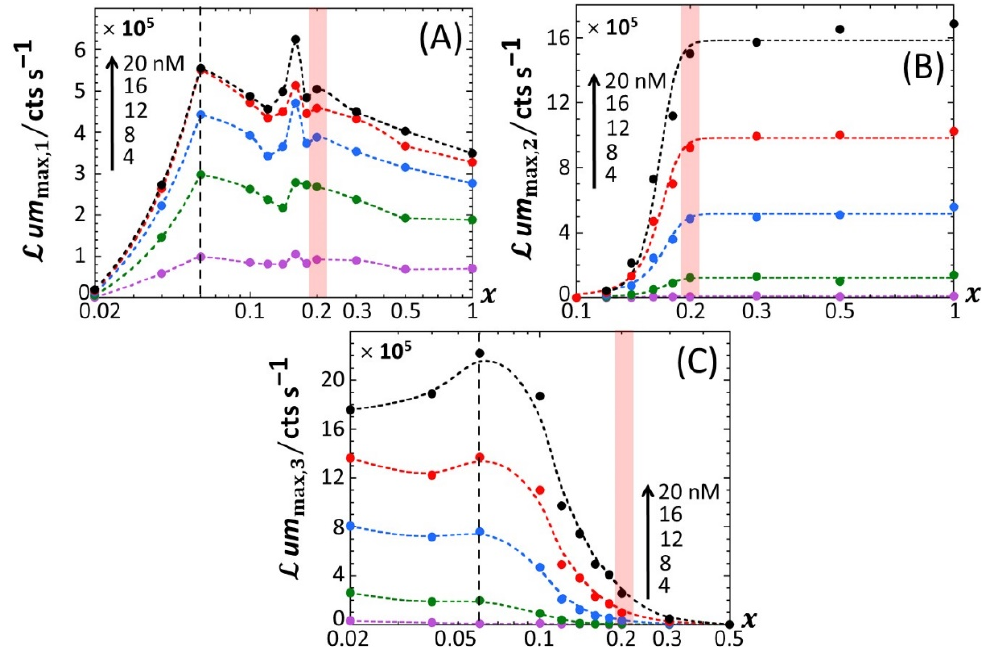
Figure 5. Variations of the maxima of the bioluminescence peaks P1 ( A ), P2 ( B ) and P3 ( C ) with x and total Cd concentration in solution (indicated). The scale in Cd concentration and associated color nomenclature specified in ( A ) apply to panels ( B , C ). (+) symbols: experimental data. Lines: guides for the eyes. The red-colored zone indicates the transition from P1–P2 to P1–P2–P3 signals. The vertical dotted lines correspond to the common positioning of the local maxima in ℒ um max,3 and the onset of the abrupt decrease in P1 amplitude with decreasing x . Measurement conditions: nGGM media supplemented with 0.1% tryptone and different concentration ratios of glucose and xylose (subsumed in the variable x ). Data in this figure originate from those given in Figure 2 (corrected for the reference at 0 nM Cd concentration).